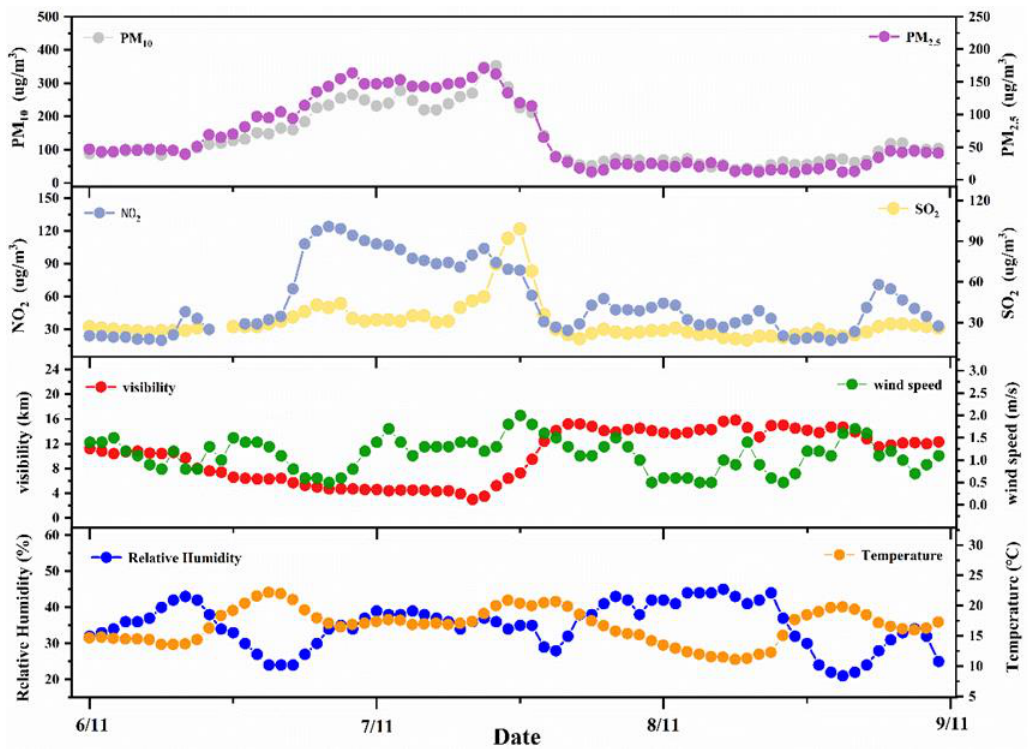
Figure 2. Meteorological conditions before, during haze, and after haze event. Meteorological conditions were monitored at Jinan Monitoring Station (117.02 ◦ E, 36.67 ◦ N; Jinan) and Quancheng conditions were monitored at Jinan Monitoring Station (117.02° E, 36.67° N; Jinan) and Quancheng Plaza (115.75 ◦ E, 36.55 ◦ N; Jinan). Data for air pollutants was obtained from Jinan Monitoring Plaza (115.75° E, 36.55° N; Jinan). Data for air pollutants was obtained from Jinan Monitoring Station.